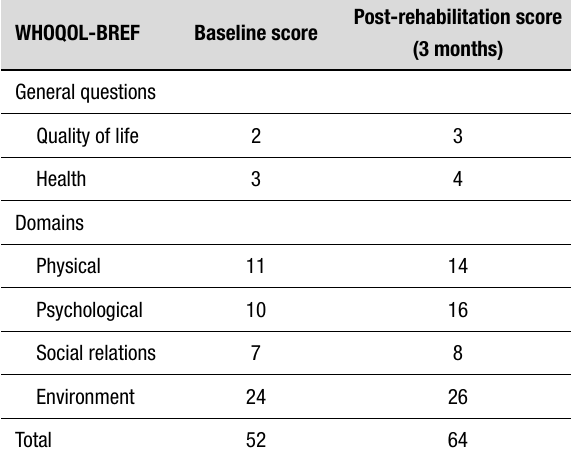
Table 3. Description of quality-of-life scores (before and after the rehabilitation program).